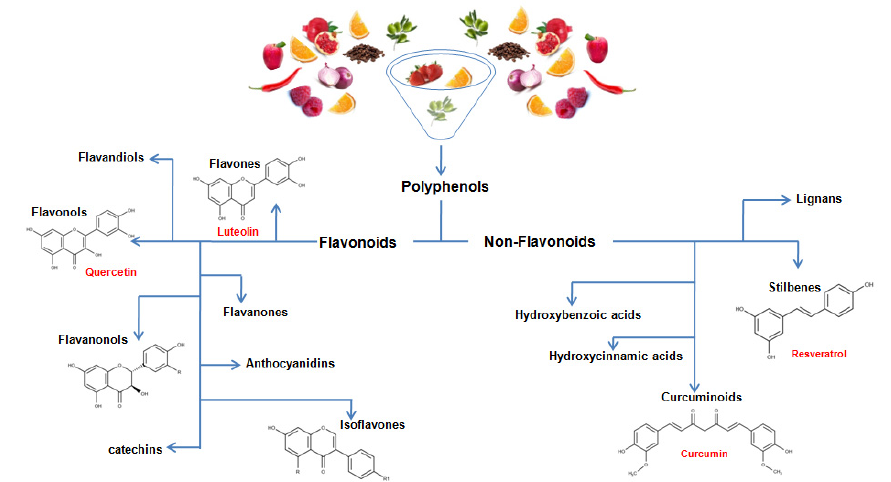
Figure 3. The various classes of flavonoids differ from each other for the degree of oxidation of the C ring and the substitutions of the A, B, and C rings [26]. In this regard, flavones, flavonols, flavanols, and flavanones are characterized by the presence of a carbonyl function on the C4 and by the presence of the aromatic ring B bound to C2, these compounds differ